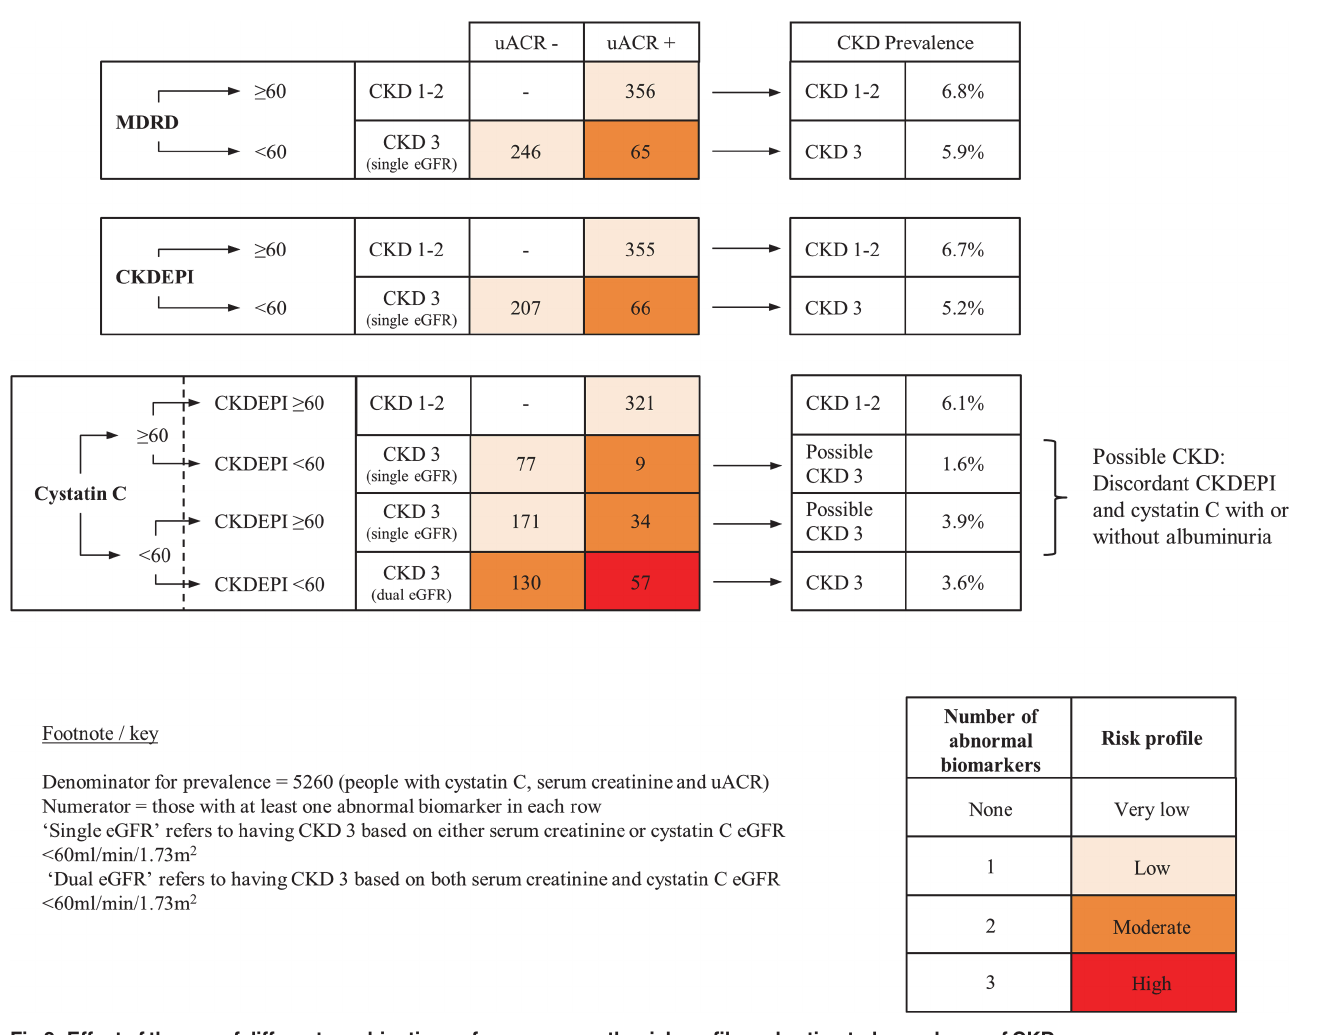
Fig 2. Effect of the use of different combinations of measures on the risk profile and estimated prevalence of